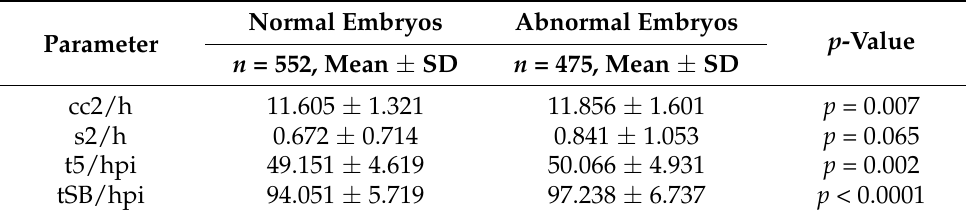
Table 1. Comparison of morphokinetic parameters in PGT-A groups of normal and abnormal